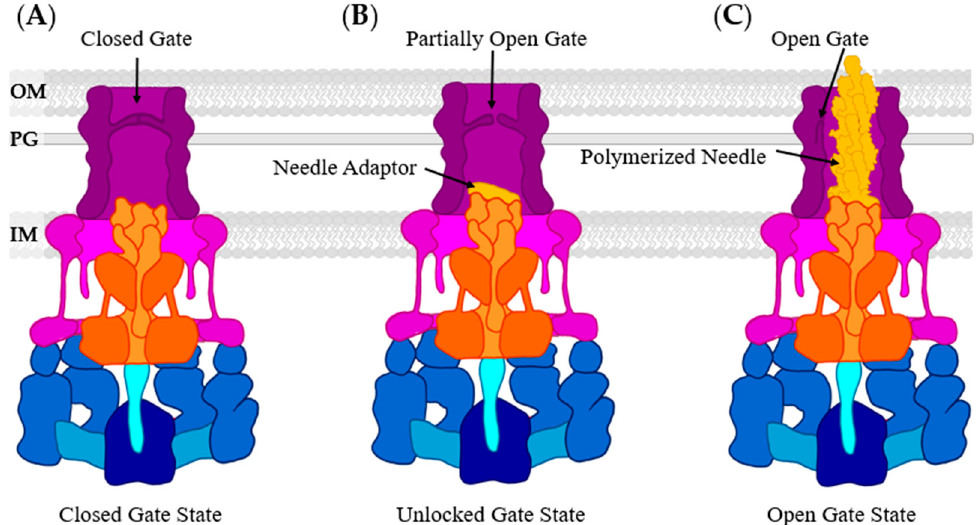
Figure 12. Periplasmic gate conformational states. ( A ) Closed gate state; ( B ) Unlocked gate state; ( C ) Open gate state. Image modified from [177]. Abbreviations: OM, outer membrane; PG, peptidoglycan; IM, inner membrane.